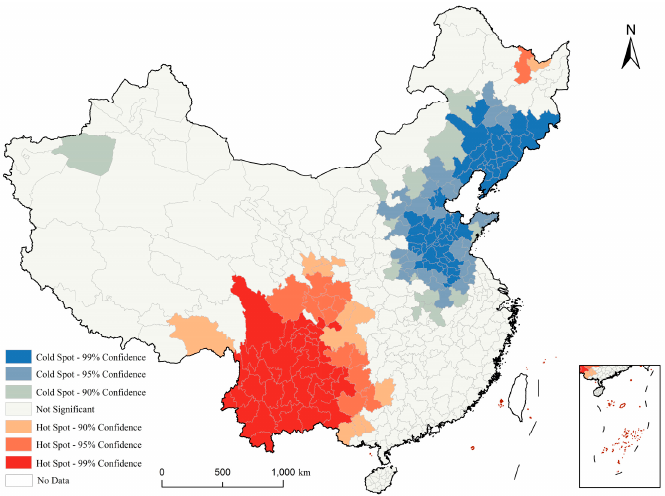
Figure 5. Getis-Ord G i * of agricultural Tfpch in